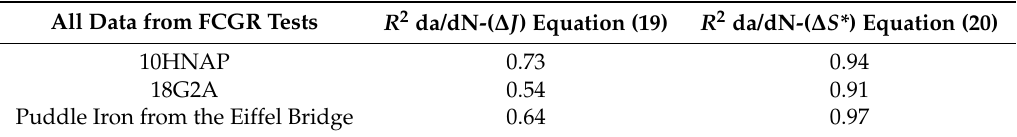
Table 4. Statistical analysis of data fitting for the Kinetic Fatigue Fracture Diagram (KFFD) based on ∆ J and ∆ S* (all R